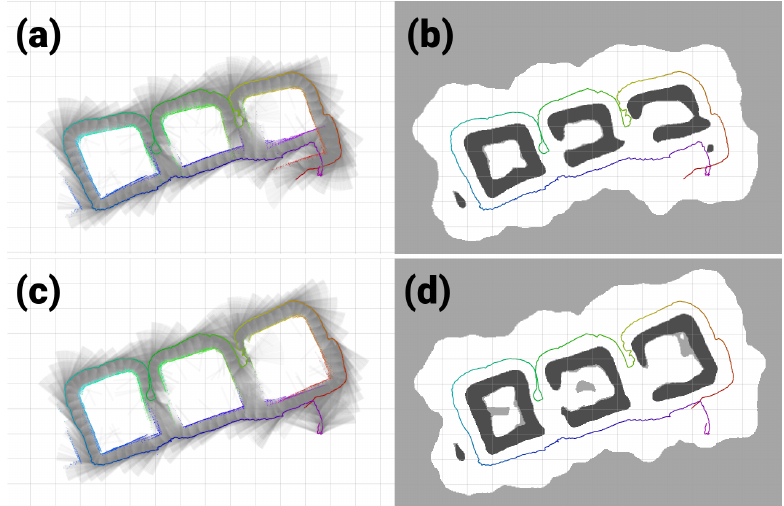
Figure 16. Breakwater dataset results. ( a , b ) Original dataset; ( c , d ) Corrected dataset; ( a , c ) Raw rays and endpoints with the vehicle trajectory colored by time; ( b , d ) Learned HM segmented to show free/unknown/occupied values with the vehicle trajectory.